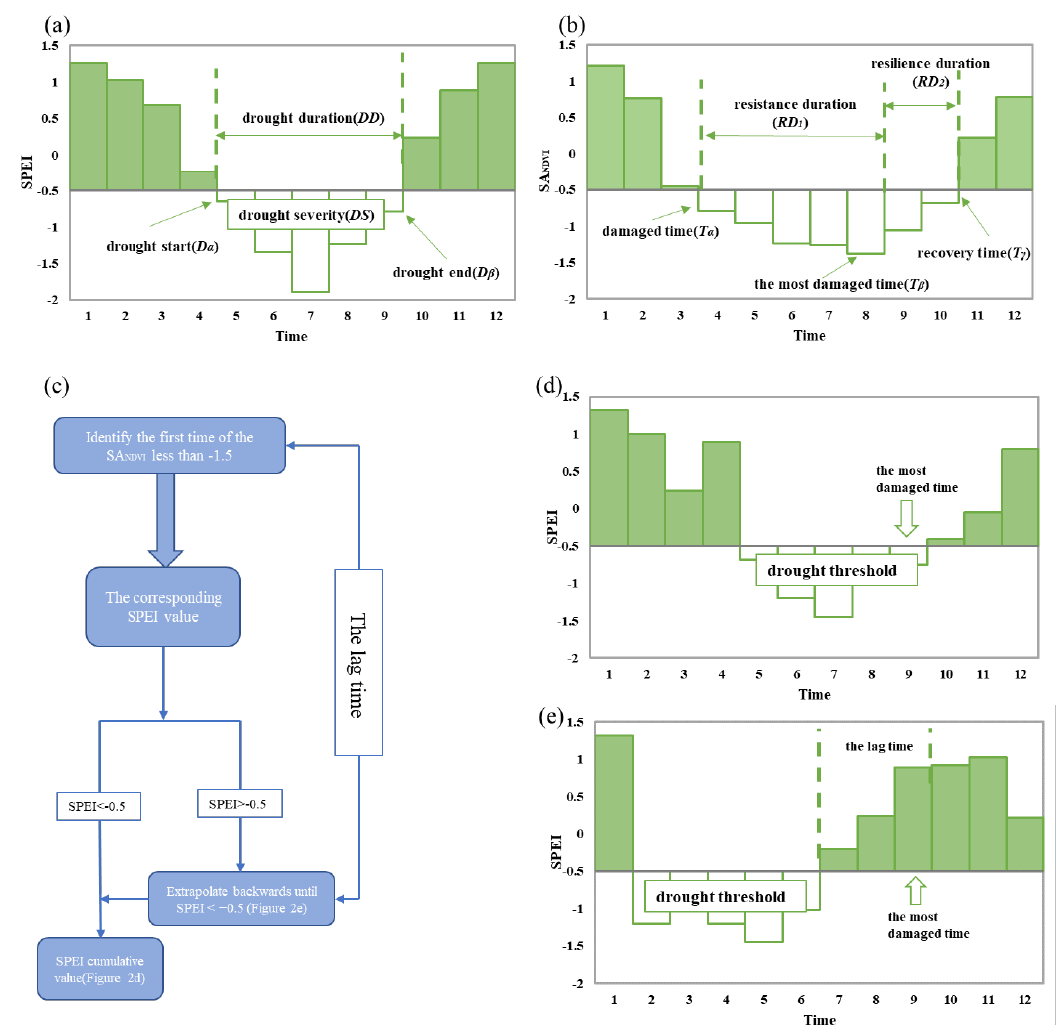
Figure 2. The identification of drought characteristics and stability parameters by smoothed SPEI and standardized anomaly of NDVI (SA NDVI ), ( a ) drought duration and drought severity, ( b ) resistance duration and resilience duration, the definition: ( c ) flow diagram, ( d ) drought threshold and ( e ) the lag time.